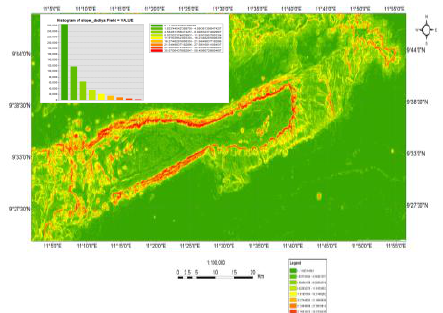
Figure 8. Slope map of the area around Dadiya (inset: histogram distribution of